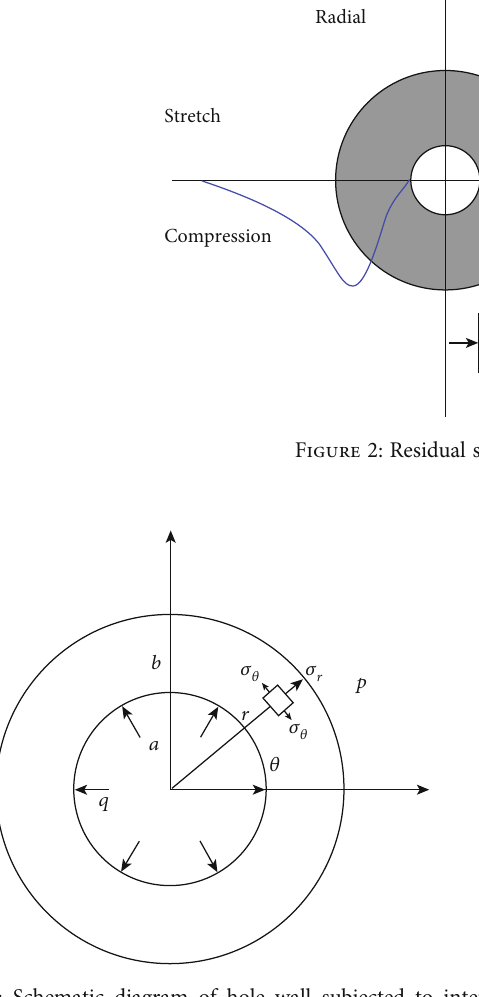
Figure 3: Schematic diagram of hole wall subjected to internal pressure.